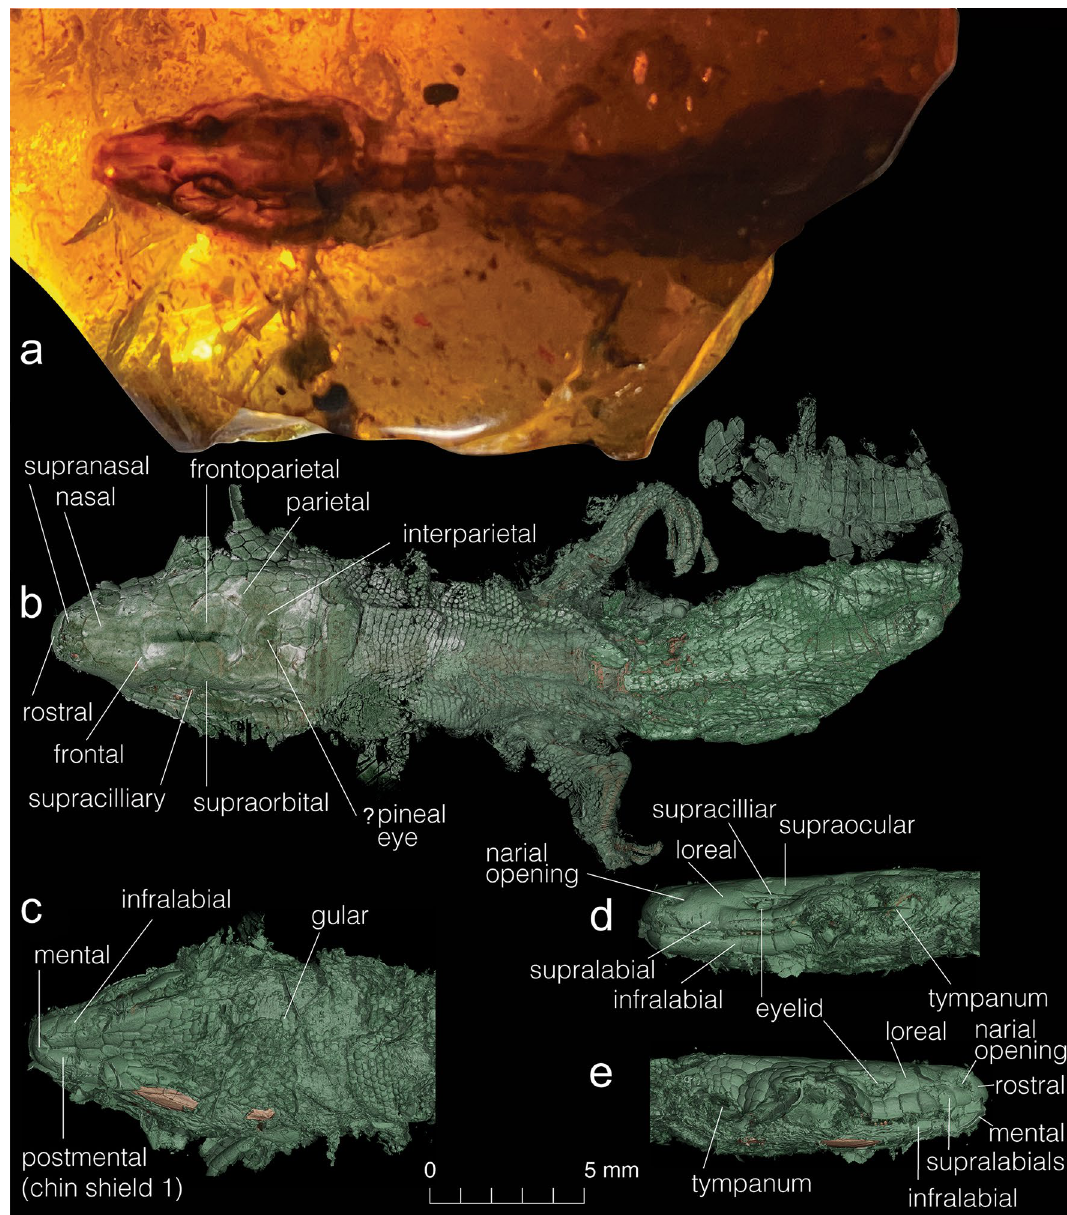
Figure 1. General view of Retinosaurus hkamtiensis (GRS 29689). ( a ) Photograph of the specimen within the amber resin in dorsal view. ( b – d ) HRCT rendering of the integument surface. Note that the integument is not visible in the photograph, as it may be preserved as a translucent layer. ( b ) dorsal view of the body, ( c ) ventral side of the head, ( d ) left lateral and ( e ) right lateral views of the head. Greenish colour indicates the skin, light brown indicates the bones preserved